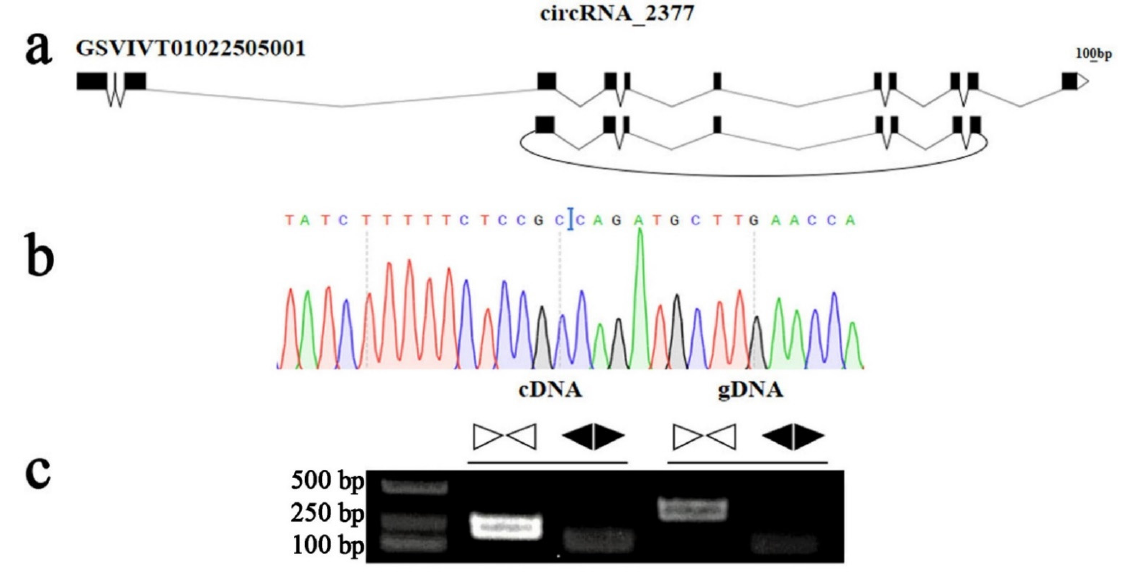
Figure 9. PCR test was conducted to validate the stable expression of grape circRNA_2377. ( a ) According to the genomic loci, circRNA_2377 derived from GSVIVT01022505001 gene. ( b ) Sanger sequencing further confirmed back-splicing site (blue line). ( c ) The agarose gel electrophoresis image showed the expected size of PCR product by divergent primers in cDNA and gDNA. ▹◃ represents convergent primers, ◂▸ represents divergent primers.